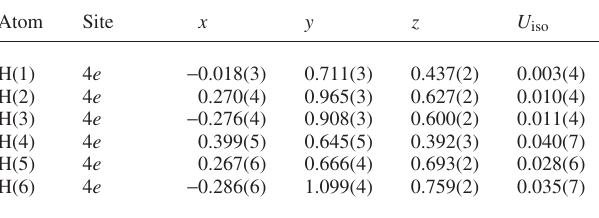
Table 2. Atomic coordinates and displacement parameters (in Å 2 )